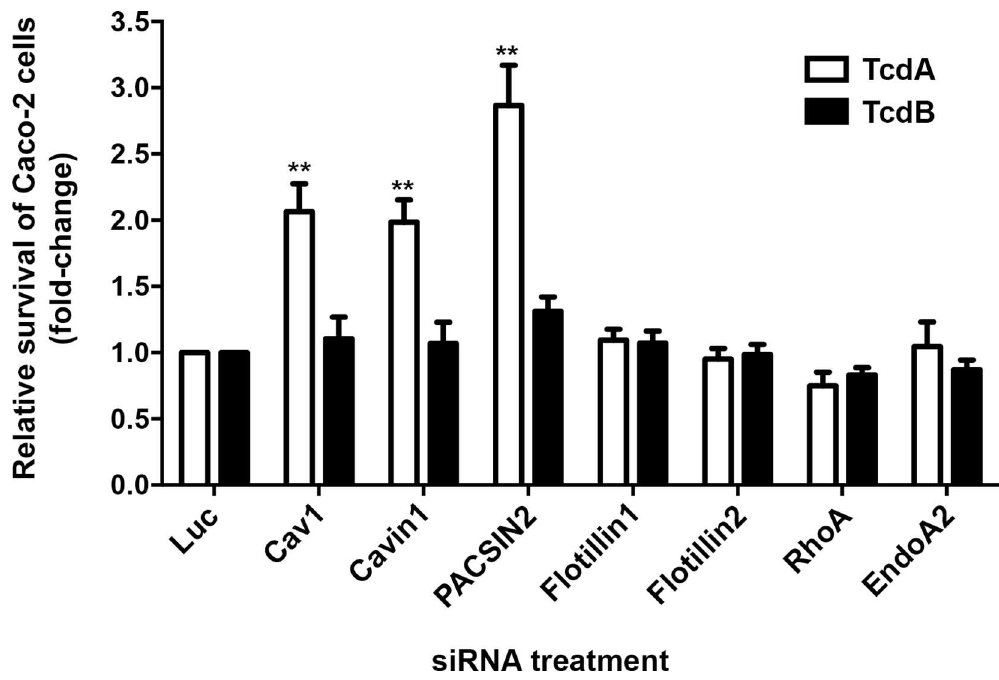
Fig 3. Depletion of caveolin1, cavin1 or PACSIN2 inhibits TcdA-induced toxicity in Caco-2 cells. Caco-2 cells were transfected with 10 nM siRNA against indicatedendocytic host factors, exposedto 50 nM TcdA (white bars) or TcdB (black bars) and then assayed for cellularviability using CellTiterGLO. Fold changeof survival was obtainedby normalizingthe relative viabilityof samples to luciferasecontrol. The data represent the averageof at least three independentexperiments performed in triplicate with the standard error of the mean indicatedas error bars. Data were analyzedusing one-wayANOVA. p-valueswere generatedusing Dunnett’s multiplecomparisons test in GraphPad Prism. ** p < 0.005.The raw viabilitydata for each siRNA target are providedin S7